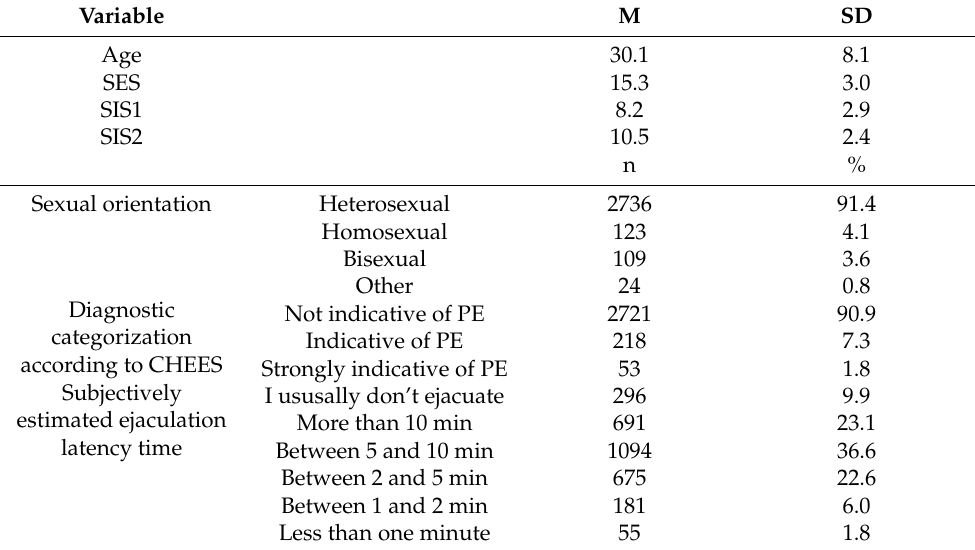
Table 1. Descriptive statistics.